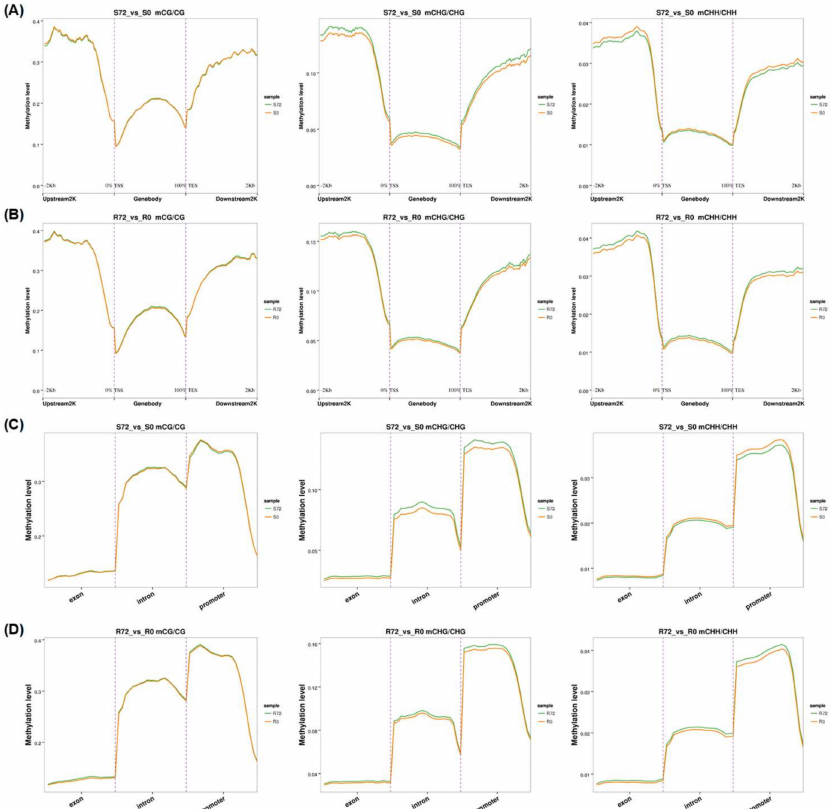
Figure 4. Comparison analysis of DNA methylation levels in di ff erent genomic functional regions in the shoots and roots of rapeseed plants under N su ffi ciency and N limitation. ( A , B ) DNA methylation levels in gene bodies and their flanking (2.0-kb upstream and downstream) regions under the CG, CHG, and CHH contexts in the ( A ) shoots and ( B ) roots. ( C , D ) DNA methylation levels in gene bodies (including exons and introns) and their promoter regions under the CG, CHG and CHH contexts in the shoots ( C ) and roots ( D ). Each functional region was equally divided into 20 bins, and the mean density of the methylated cytosines was defined as the methylation density in each bin. S, shoot; R, root. The times of 0 h and 72 h refer to the time after treatment of N